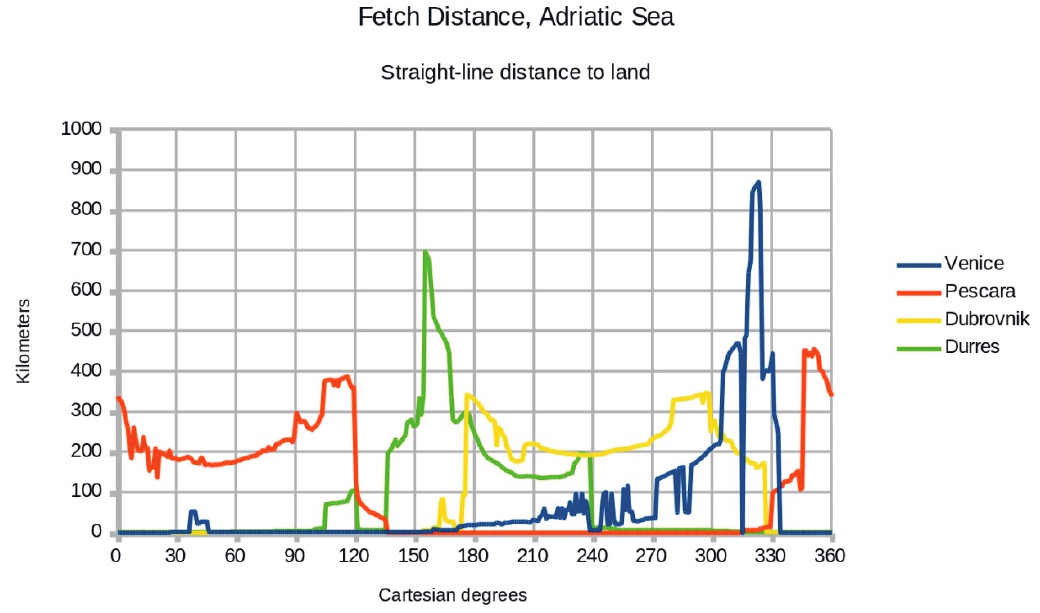
Figure 4. Fetch distance by compass direction for ports on the Adriatic